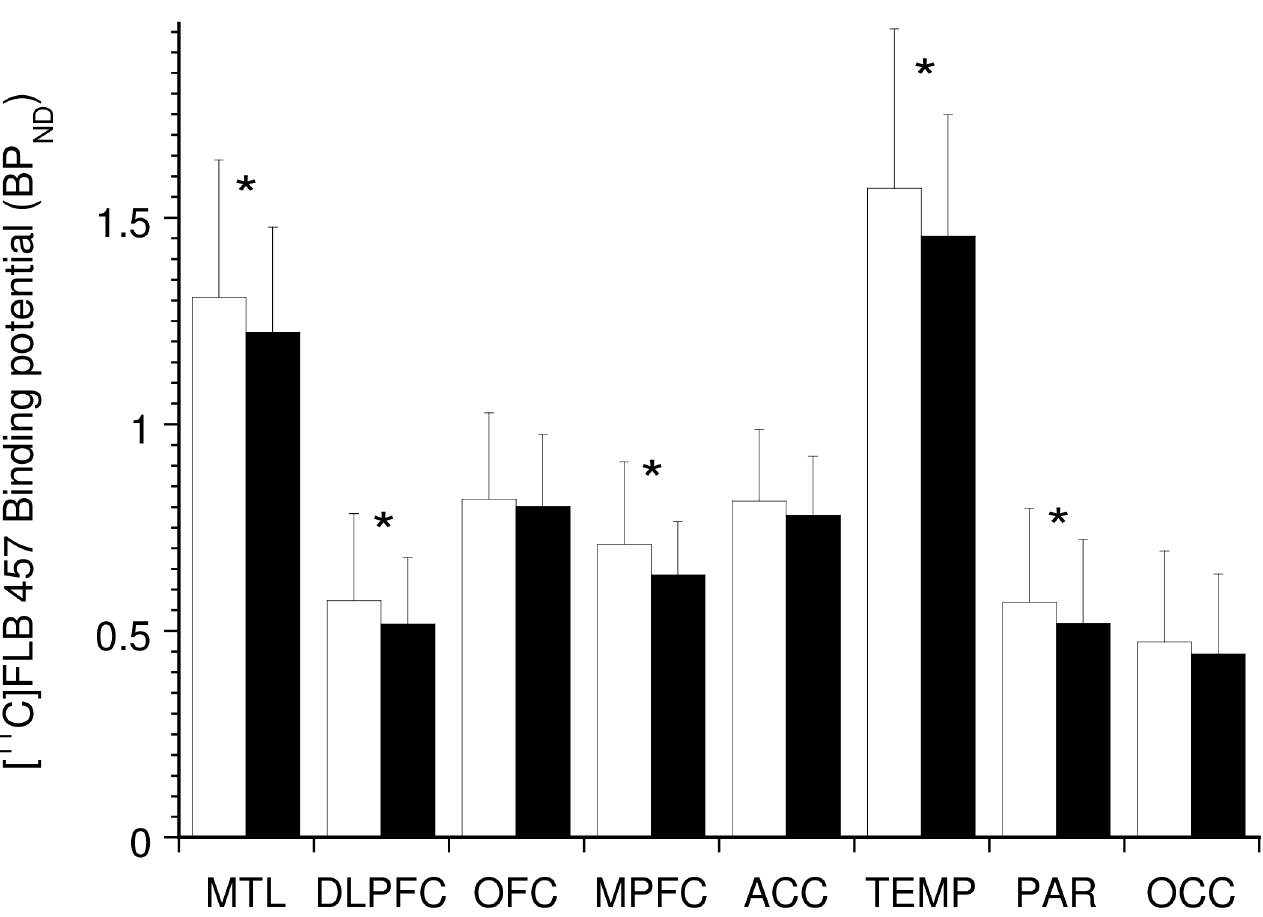
Fig 2. Amphetamine-Induced Displacement of [ 11 C]FLB 457 Binding Potential. The bar graph shows [ 11 C]FLB 457 BP ND under baseline (white bars) and post-amphetamine (black bars) conditions in n = 31 healthy subjects. Amphetamine led to a significant decrease in five of the eight cortical regions of interest ( * denotes p < 0.05, paired t-tests) consistent with previous reports [9 – 11].